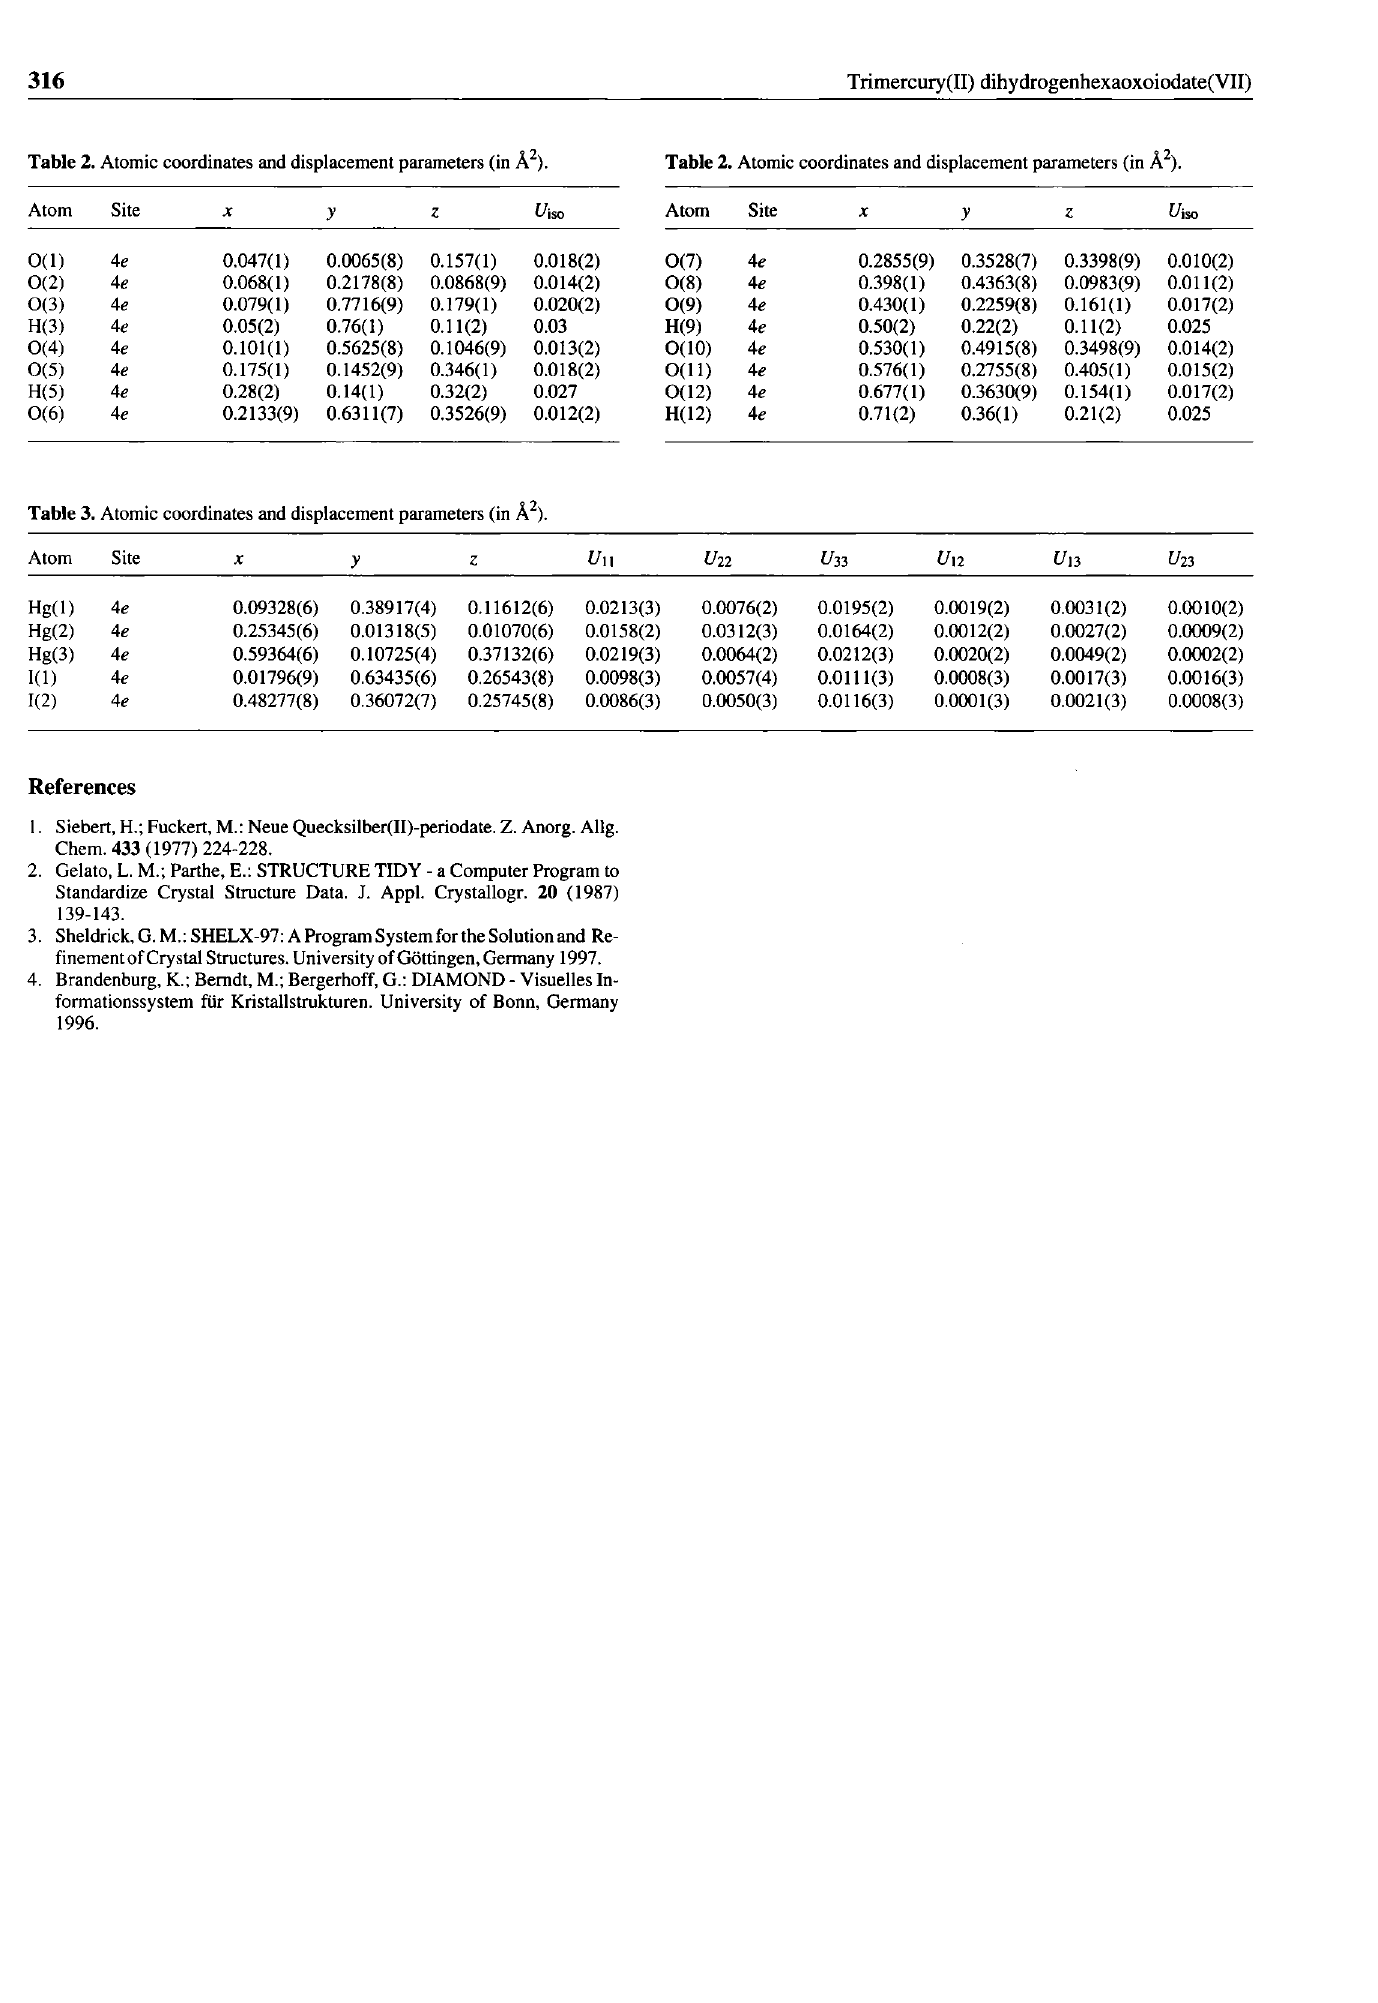
Table 2. Atomic coordinates and displacement parameters (in Ä 2 ).